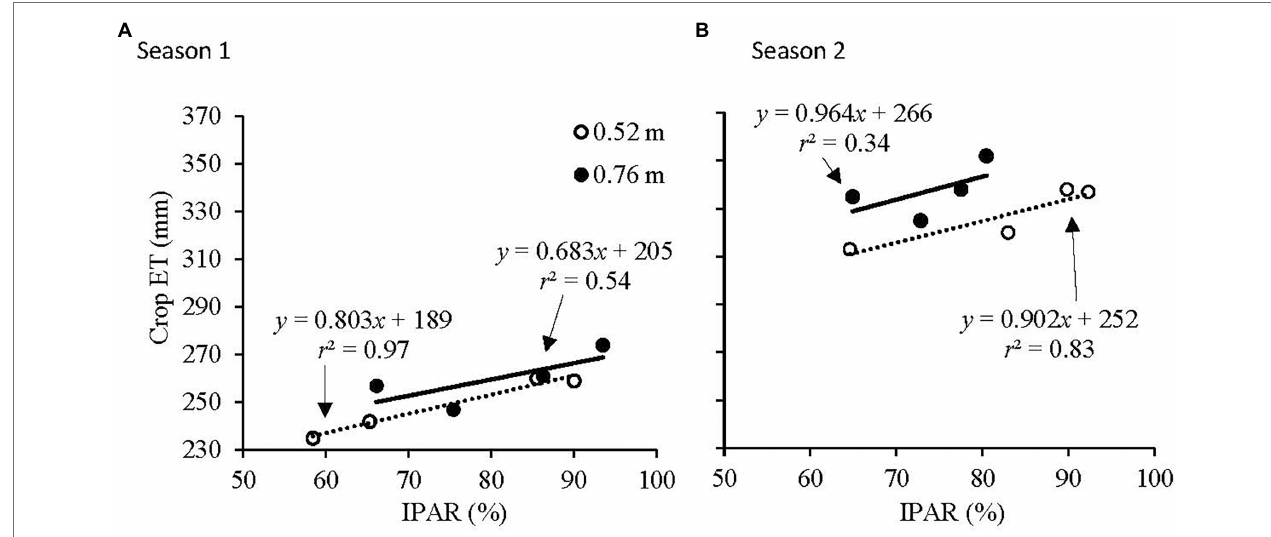
FIGURE 2 | Relationship of seasonal crop evapotranspiration (crop ET) to intercepted photosynthetically active radiation (IPAR) at 0.52 and 0.76 m row spacings in (A) Season 1 and (B) Season 2.